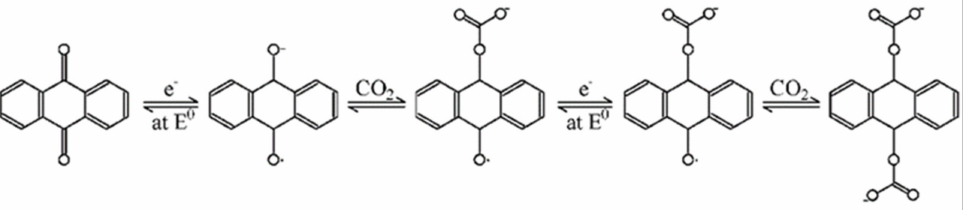
Figure 7. Reduction principle of anthraquinone in the presence of CO 2